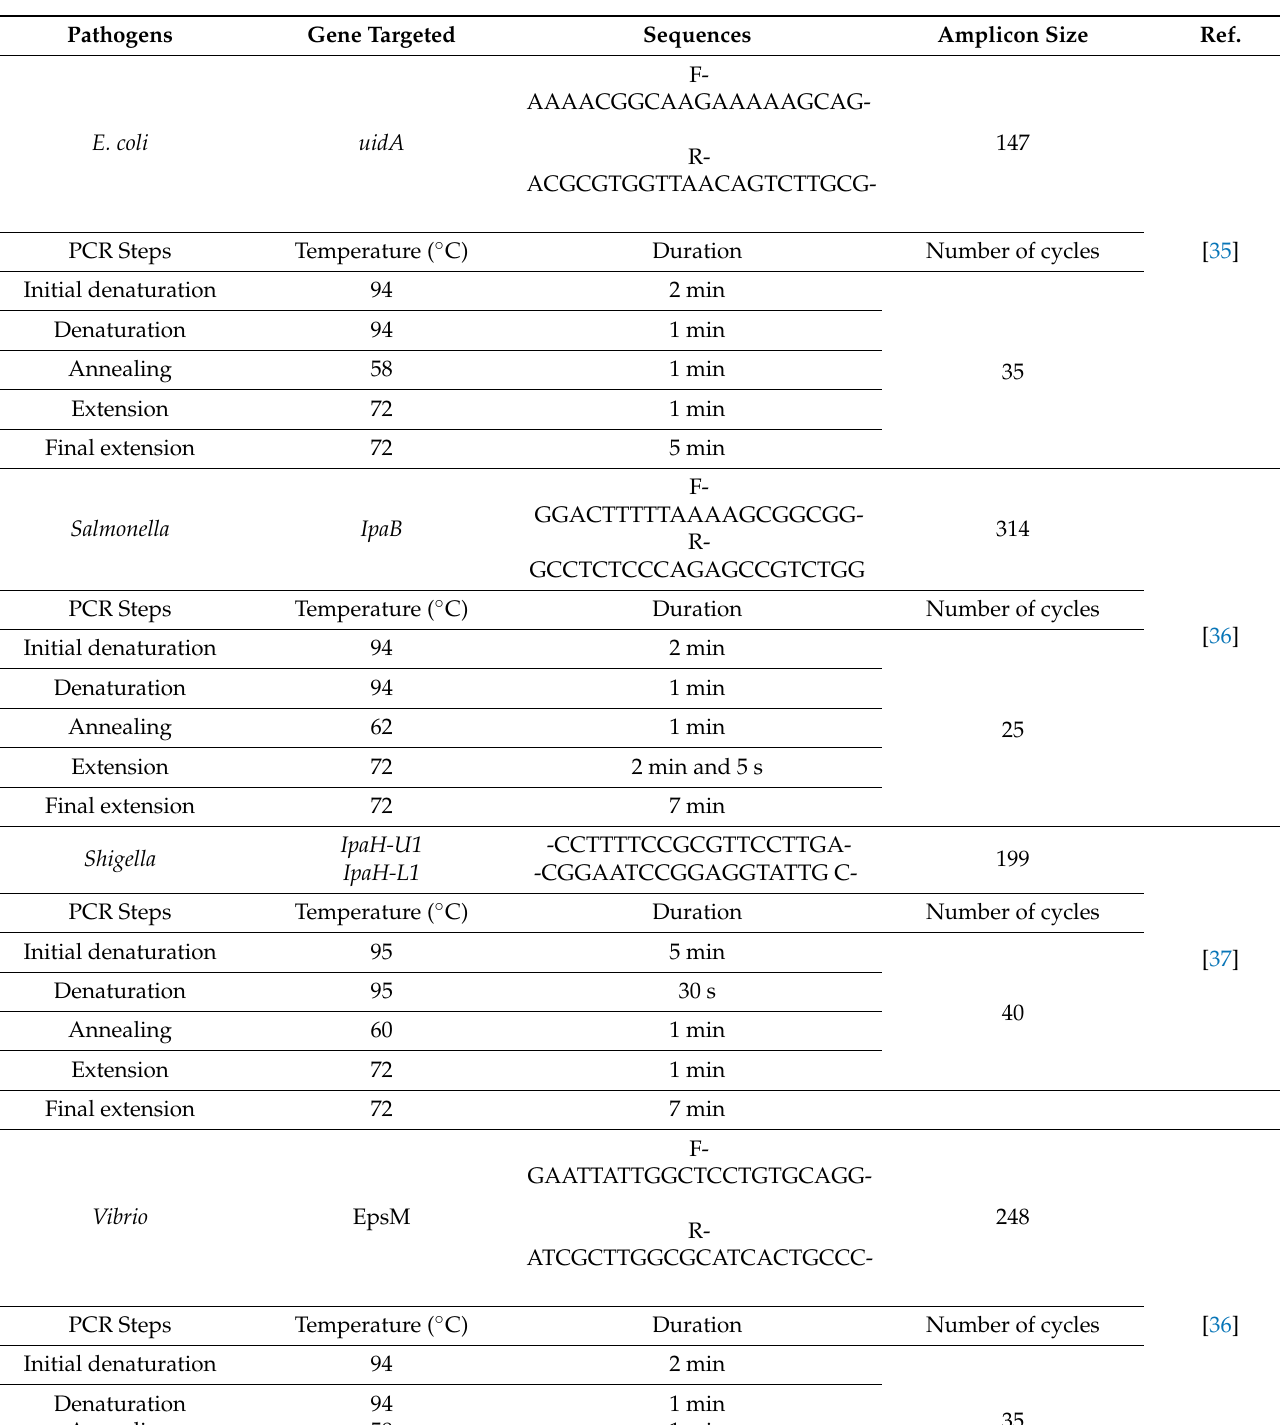
Table 1. PCR oligonucleotide primers used to detect E. coli , Salmonella , Shigella , and Vibrio